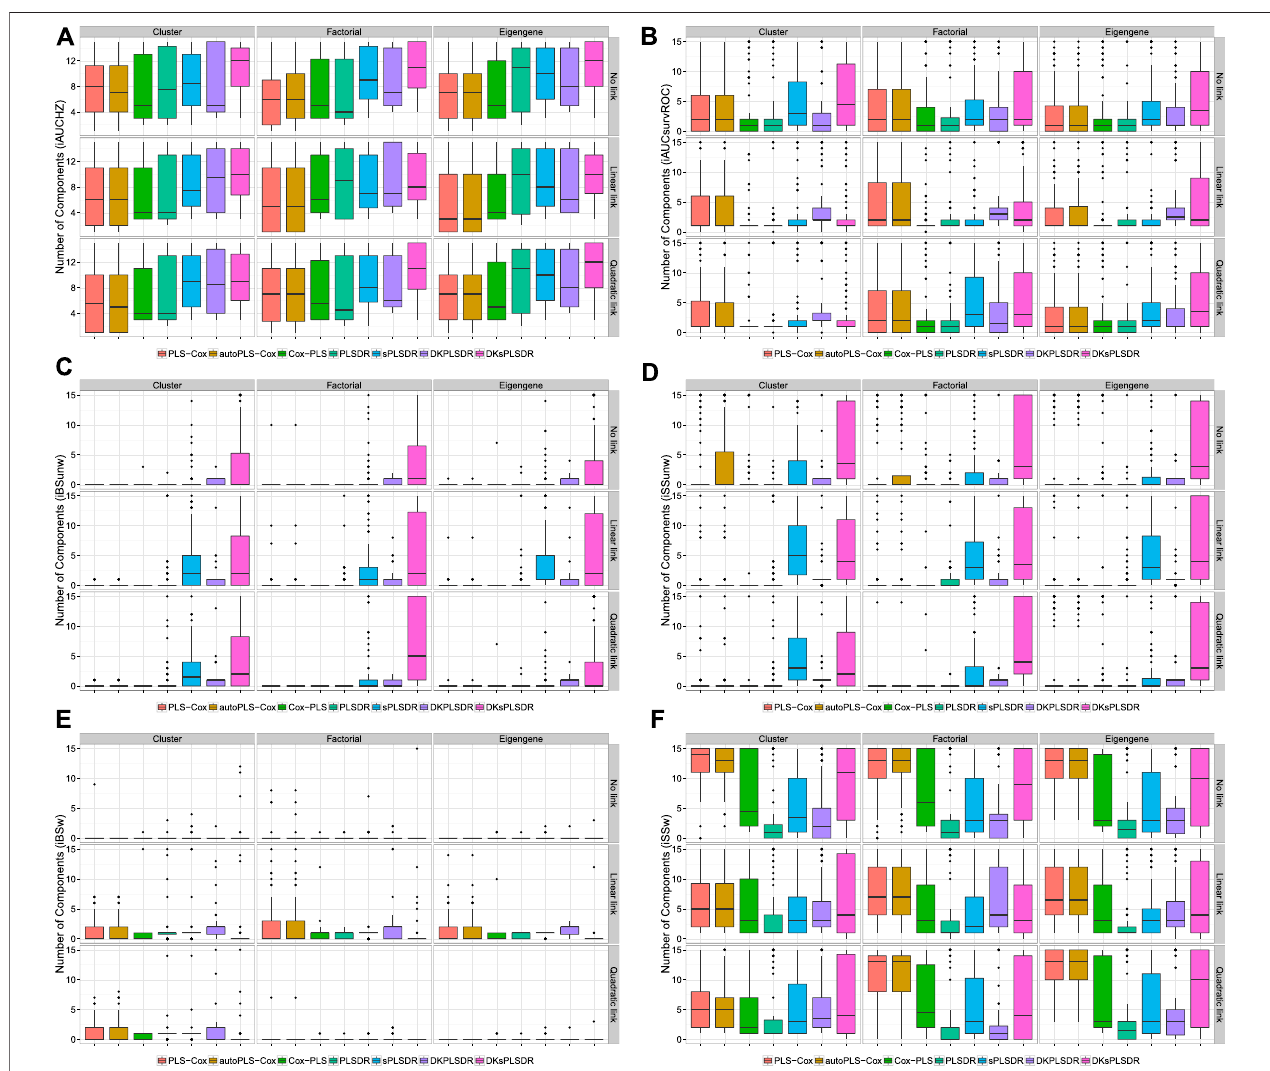
FIGURE2| Numberofcomponents.panel (A) :iAUCHZcriterion.panel (B) :iAUCSurvROC criterion.panel (C) :iBSunwcriterion.panel (D) :iSSunwcriterion.panel (E) : iBSw criterion. panel (F) : iSSw criterion.